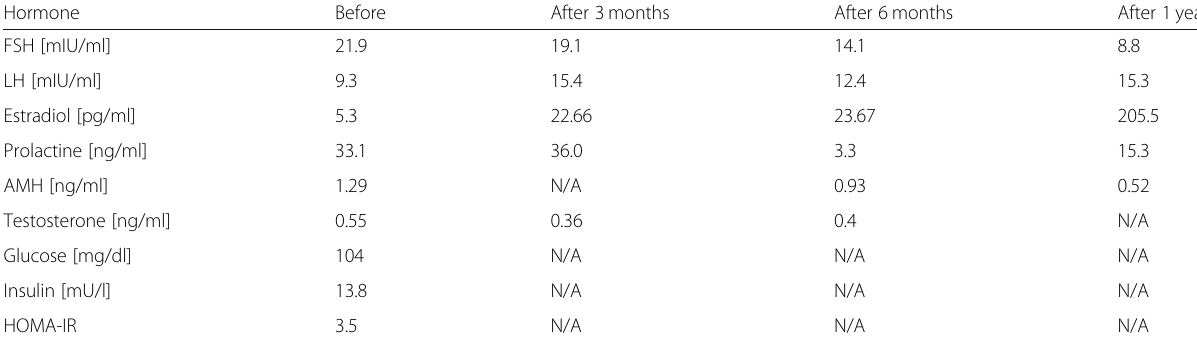
Table 1 Hormone profiles during observation